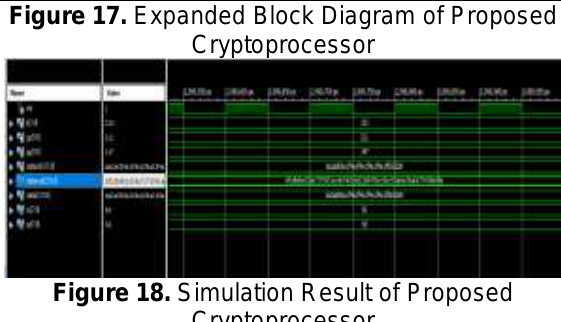
Figure 17. Expanded Block Diagram of Proposed